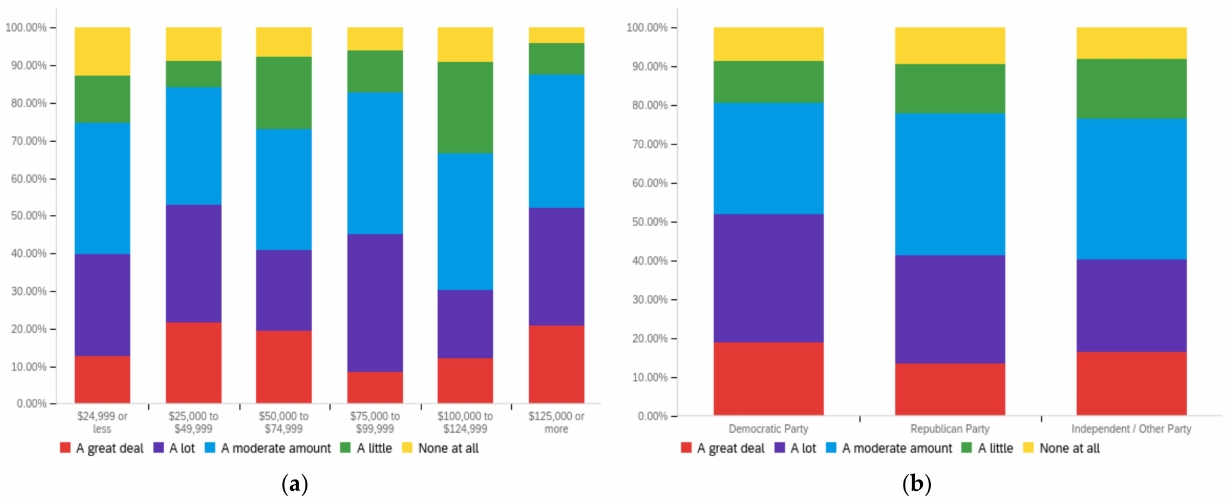
Figure A26. Cont